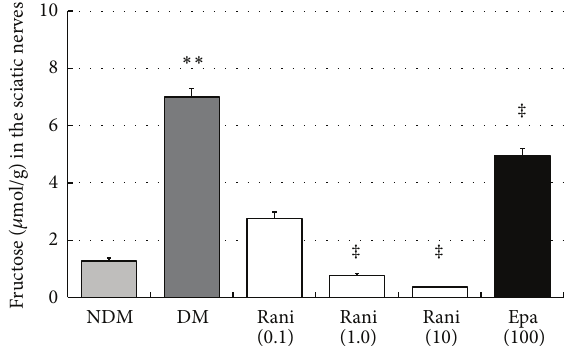
Figure 13: The fructose levels in the sciatic nerves at 15 weeks. The fructose level in the sciatic nerves of the untreated SDT rats is significantly higher that of the SD rats. ∗∗ 𝑃 < 0.01 , Student’s 𝑡 -test. The fructose levels in the sciatic nerves treated with ranirestat (1.0 and 10mg/kg/day) are significantly lower than in the untreated SDT rats. ‡ 𝑃 < 0.01 , Dunnett type joint-ranking test. The fructose levels in the sciatic nerves treated with epalrestat are also significantly lower than in the untreated SDT rats. ‡ 𝑃 < 0.01 , Student’s 𝑡 -test. NDM: non-diabetes mellitus; DM: diabetes mellitus; rani: ranirestat; epal: epalrestat.